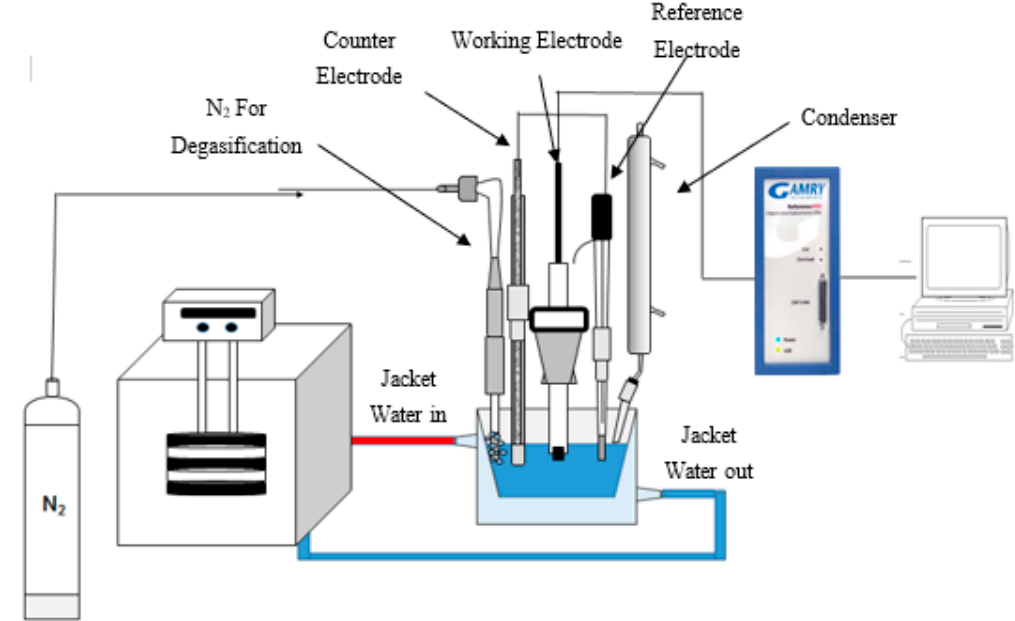
Figure 1. Schematic diagram of the experimental setup.